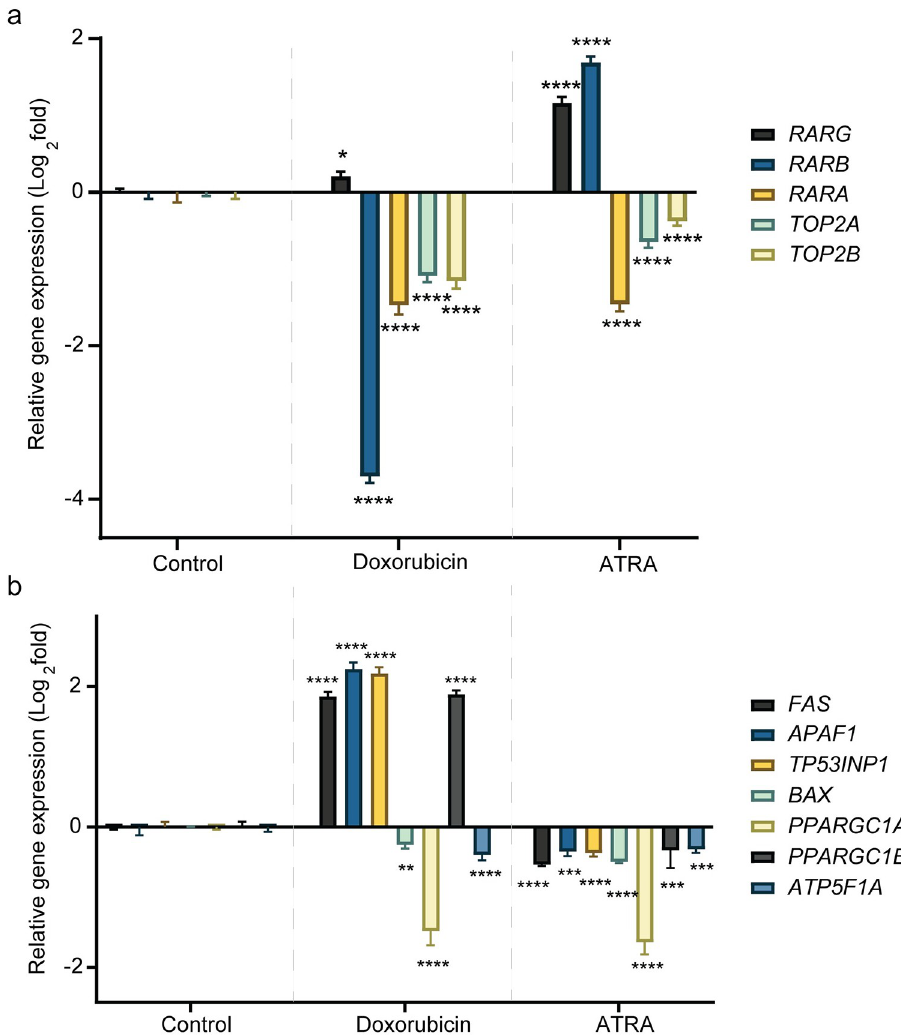
Fig 2. ATRA regulates RAR genes, TOP2 genes, and downstream ACT response genes in human cardiomyocytes. (a) Fold-change in gene expression of RARG , RARB , RARA , TOP2A and TOP2B during control (vehicle) or doxorubicin (1 μ M) or ATRA (500 nM) treatment. Data are presented as mean ± standard deviation (two independent experiments were performed, the extracted RNA was combined, and gene expression assay was performed as three technical replicates, N = 3). Statistical analysis was performed using two-way ANOVA and Bonferroni multiple comparisons correction (comparisons between the control vs. doxorubicin and control vs. ATRA are shown, � , and ���� denote P = 0.012, P < 0.0001, respectively). (b) Fold-change in gene expression of the genes involved in doxorubicin-induced apoptosis ( FAS , APAF1 , TP53INP1 , and BAX ) and doxorubicin-induced mitochondrial dysfunction ( PPARGC1A , PPARGC1B , and ATP5F1A ) during control (vehicle) or doxorubicin (1 μ M) or ATRA (500 nM) treatment. Data are presented as mean ± standard deviation (two independent experiments were performed, the extracted RNA was combined, and gene expression assay was performed as three technical replicates, N = 3). Statistical analysis was performed using two-way ANOVA and Bonferroni multiple comparisons correction (comparisons between the control vs. doxorubicin and control vs. ATRA are shown, �� , ��� and ���� denote, P = 0.0059, P < 0.001 and P < 0.0001, respectively). showed significant downregulation of Top2a expression (doxorubicin-only treated mice: decreased to -0.9-fold, P < 0.0001 and ATRA + doxorubicin-treated mice decreased to -1.5-fold, P < 0.0001). Moreover, the ATRA + doxorubicin-treated group showed significantly reduced Top2a expression than the doxorubicin-only treated group (P = 0.0009) (Fig 3).